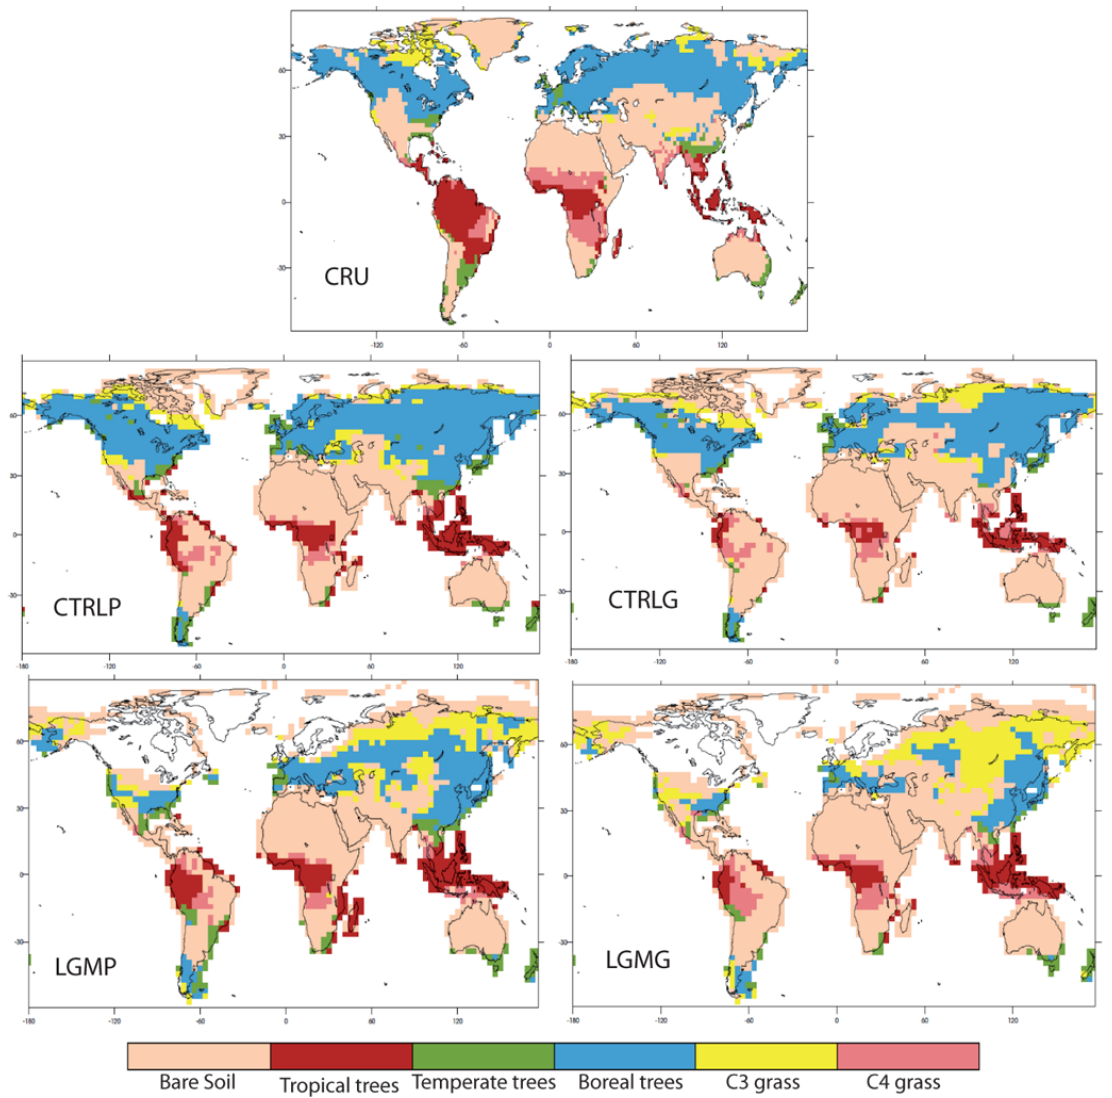
Fig. 3. Dominant PFT type simulated by ORCHIDEE forced off-line by monthly CRU data (CRU) or by high-frequency outputs of the IPSL CM4 v1 GCM for present-day climate (CTRLP and CTRLG) and LGM climate (LGMP and LGMG). Abbreviations: see Table 2. For each grid-cell we consider the fraction of bare soil, C3 and C4 grasses, and the sum of the tree PFT fractions of a given tree type (tropical, temperate, and boreal). The dominant type is the one occupying the greatest cell fraction, without considering its absolute